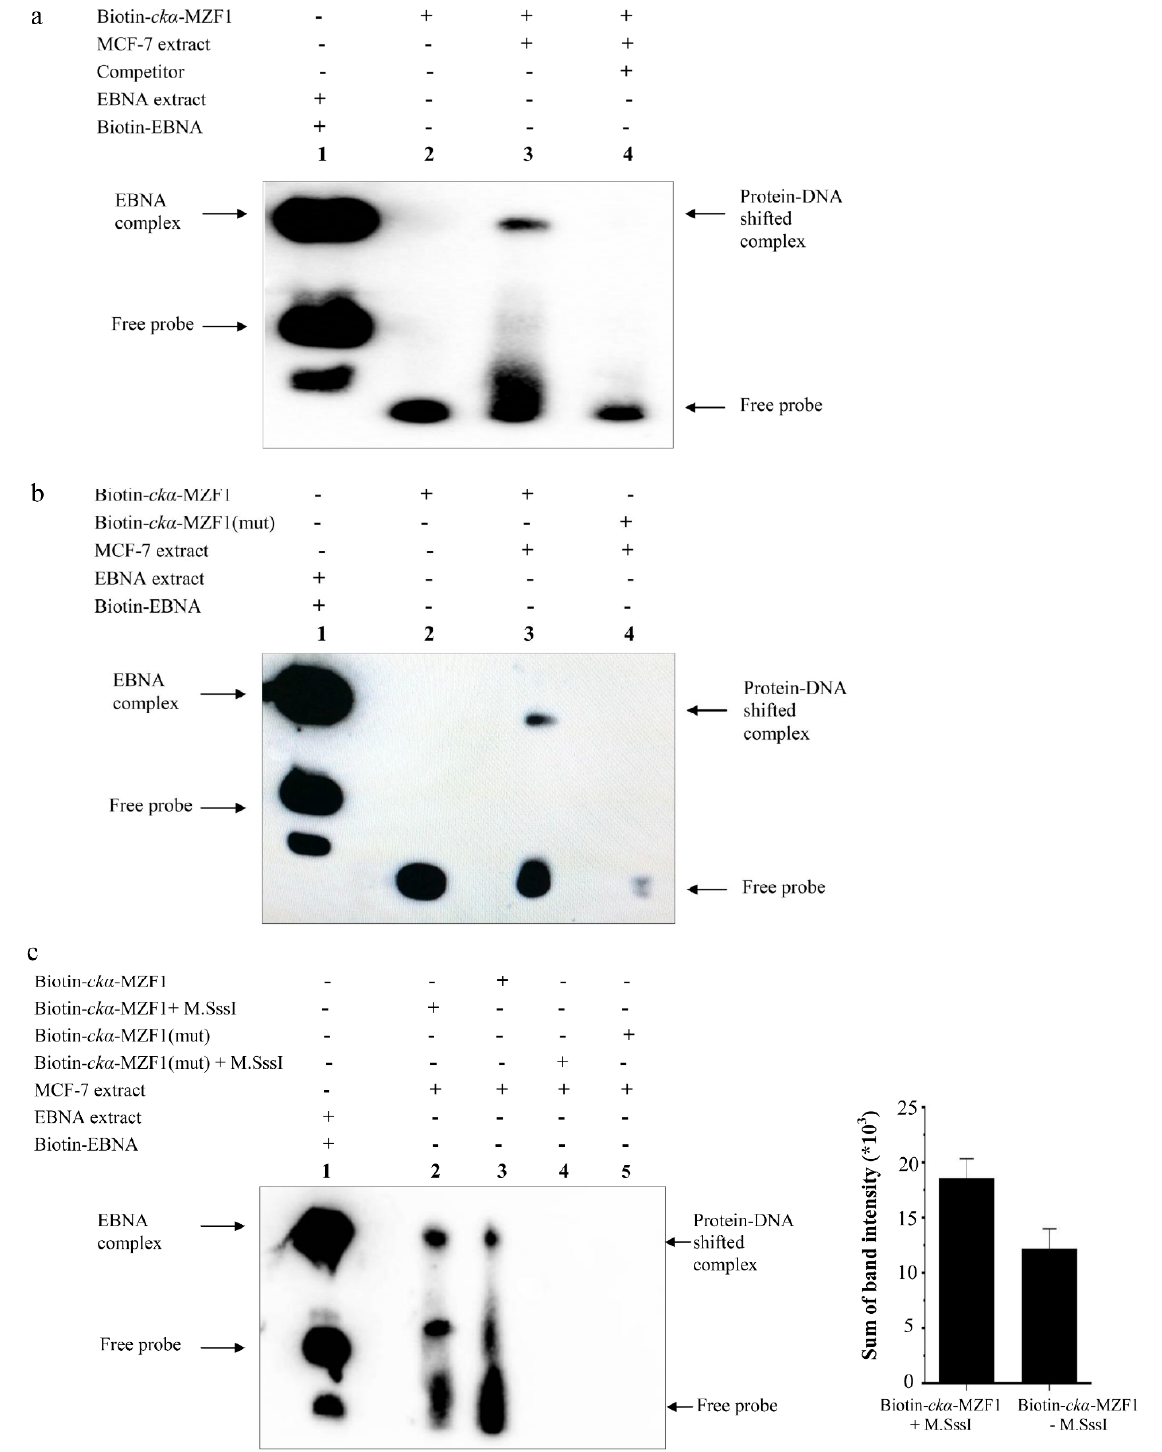
Figure 6. DNA methylation induces the binding of MZF1 to CpG4 of ck α promoter. ( a ) EMSA showing putative MZF1 transcription factor binding to ck α promoter; ( b ) mutation of MZF1 binding site abolishes the binding of putative MZF1 to ck α promoter; and ( c ) in vitro methylation CpG4 promotes the putative MZF1 binding. Histogram depicting band intensity data obtained from ImageJ. The error bars represent SEM from two independent experiments.